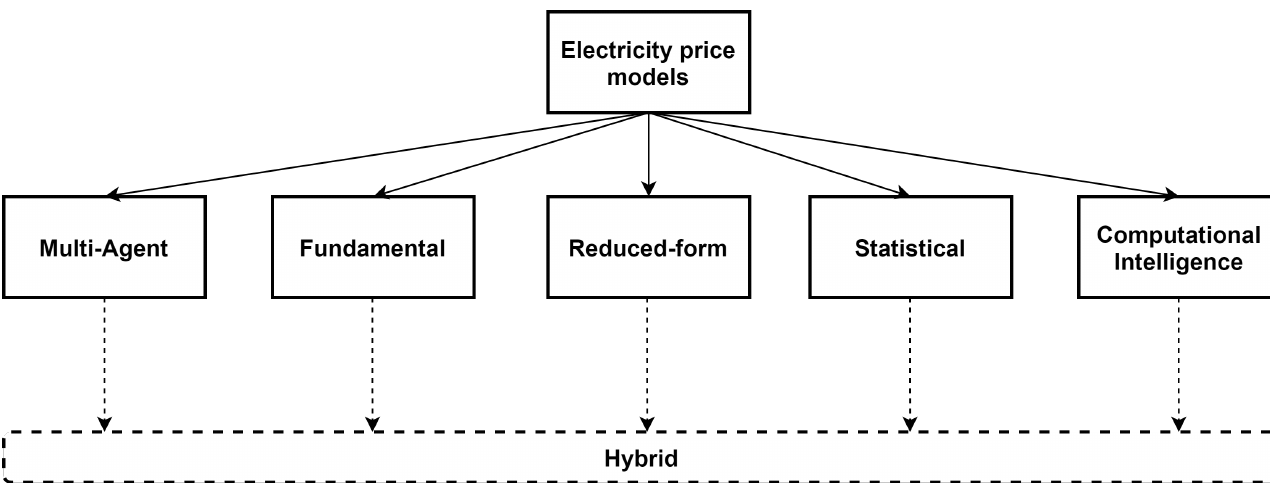
Figure 1. Taxonomy of electricity price modelling approaches. The main model types could be combined as hybrid models.